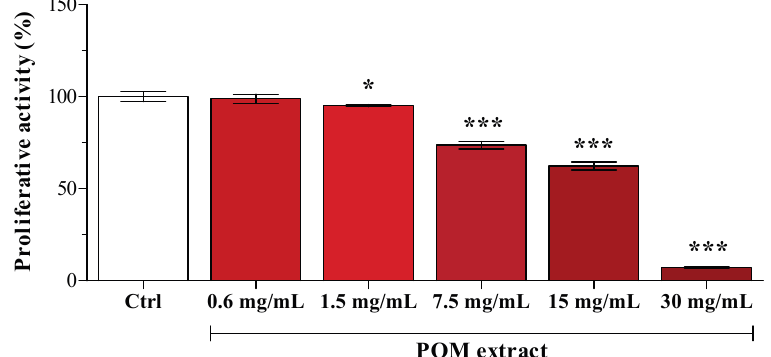
Figure 1. Cell viability after supplementation with different POM concentrations. Data are expressed as the percentage of the value obtained in unsupplemented cells (Ctrl), assigned as 100%. Statistical analysis was carried out by one-way ANOVA ( p < 0.001) using Dunnett’s post test ( * p < 0.05, *** p < 0.001 vs. Ctrl cells).